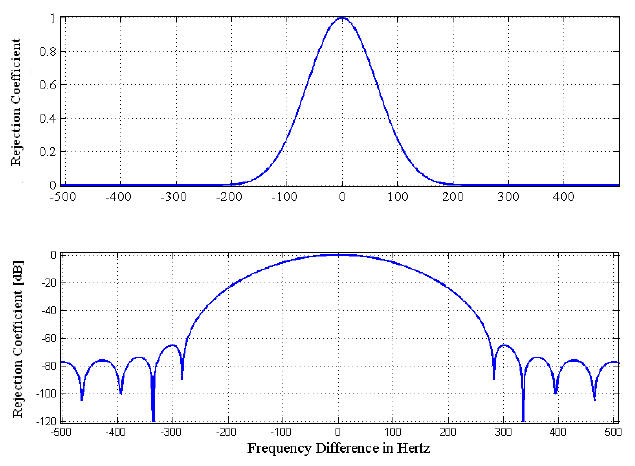
Figure 2. Behavior of the rejection coefficient in linear and logarithmic scale vs frequency difference δ